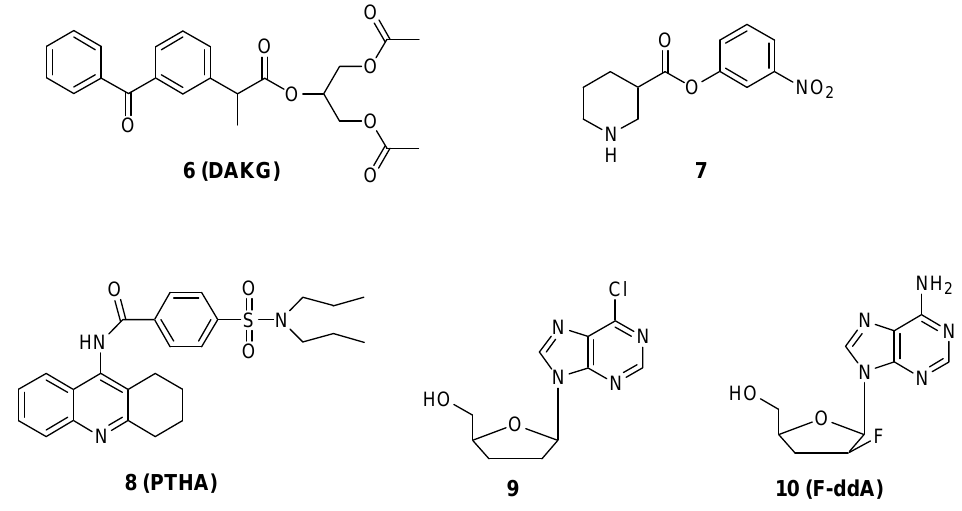
Figure 3. Chemical structures of DAKG, nipecotic acid m -nitrophenyl ester, 6-chloro- 2’,3’-dideoxypurine, F-ddA and